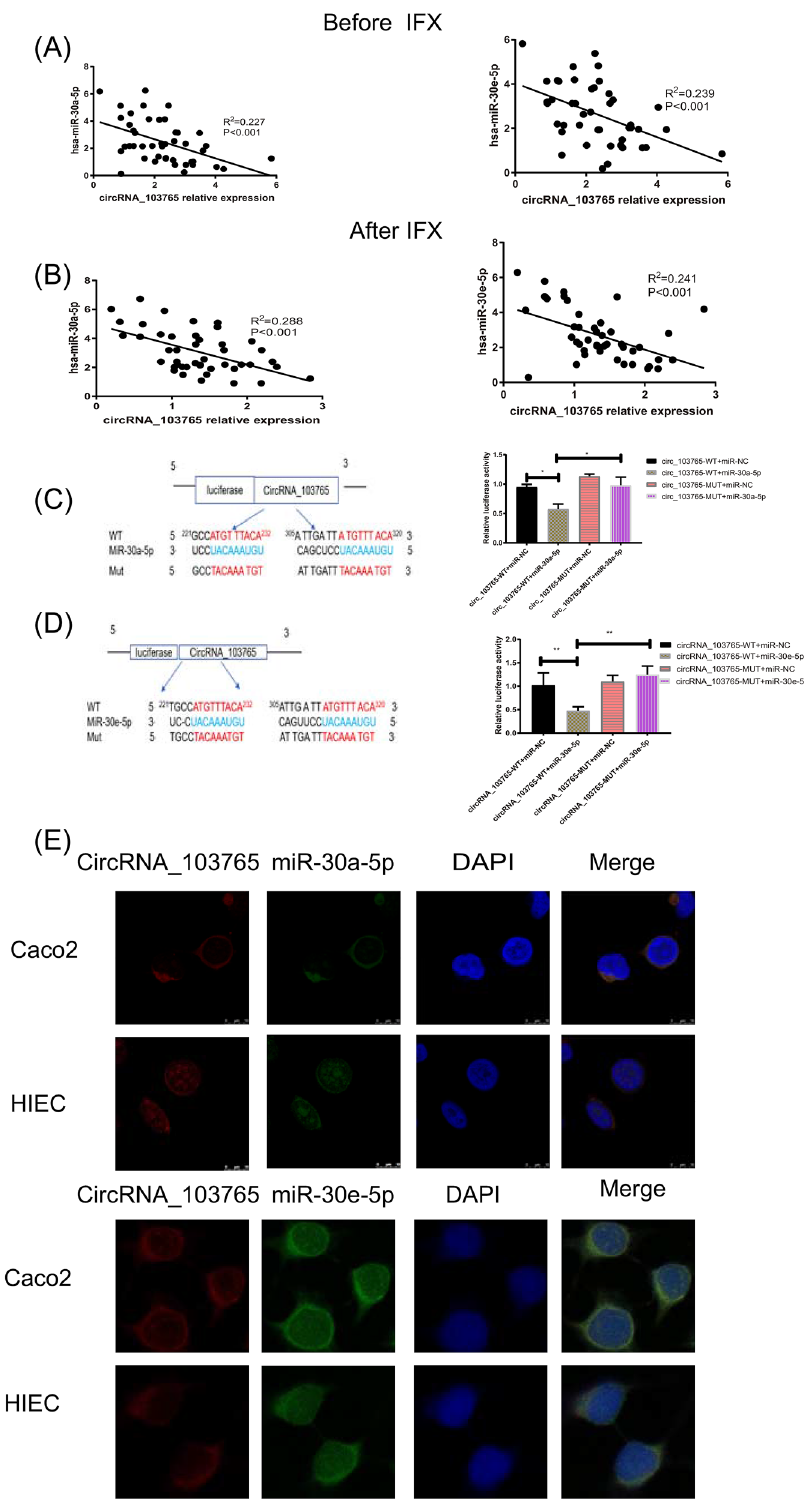
Figure 5. CircRNA_103765 functions as a sponge for miR-30 family. ( A , B ) Correlations of circRNA_103765 expression with miR-30a-5p and miR-30e-5p in active CD patients prior to and after IFX treatment (n = 45). ( C , D ) Schematic illustration of circRNA_103765-WT and circRNA_103765-Mut luciferase reporter vectors. The relative luciferase activities were detected in 293T cells after transfection with circRNA_103765-WT, circRNA_103765-Mut and miR-30a-5p/miR-30e-5p mimics or miR-NC, respectively. ( E ) FISH was performed to observe the cellular location of circRNA_103765 (red) and miR-30a-5p/miR-30e-5p (green) in cells (magnification, × 40, scale bar, 10 μm). *p < 0.05, **p <